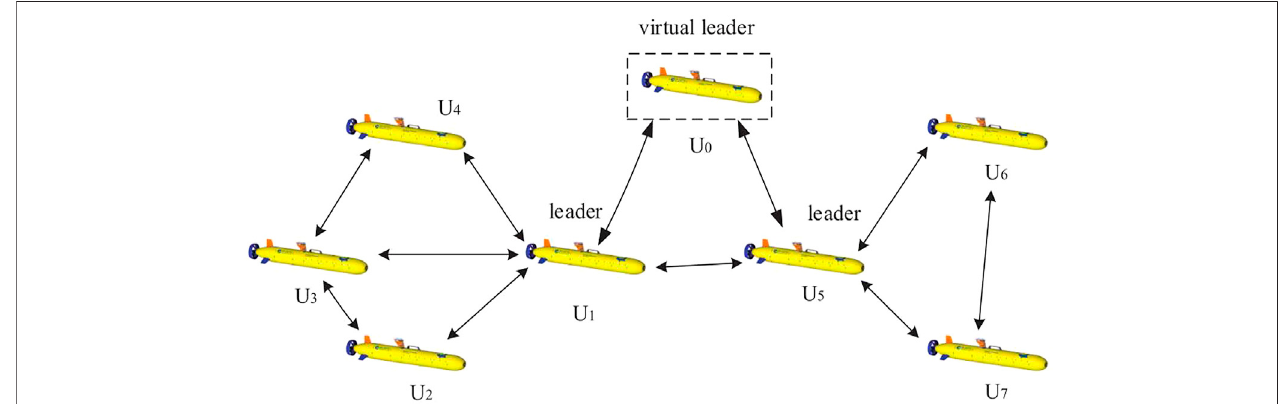
FIGURE 2 | Hybrid communication